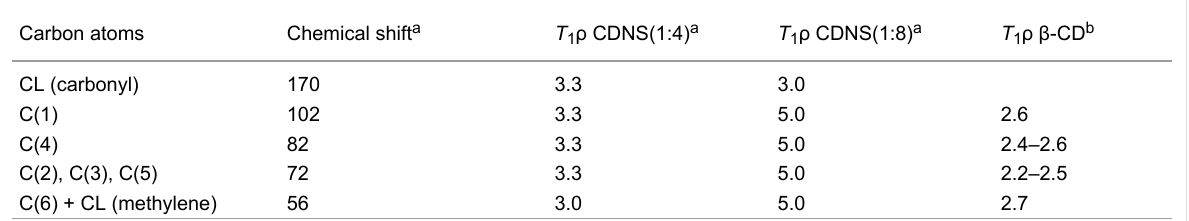
Table 1: Chemical shift (ppm), and proton relaxation T 1 ρ (ms) of the carbon atoms of CDNS(1:4), CDNS(1:8) polymers and pristine β